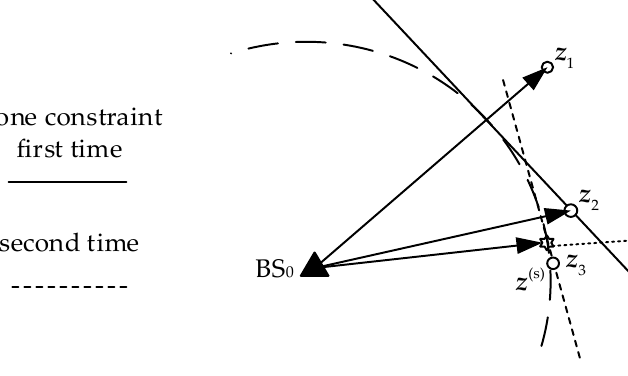
Figure 7. The position change after twice Cone constraint correction.